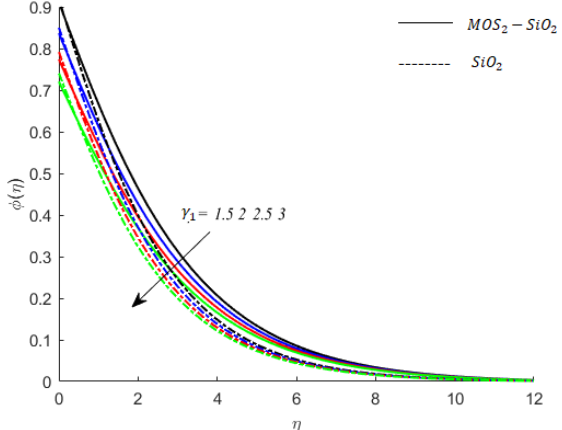
Figure 12. Influence of γ 1 on concentration when M = 0.9, Pr = 0.9, Ec = 0.2, Sc = 0.8, K = 0.1, Ei = 0.1, Bi = 0.05, β ∗ = 0.1, γ = 0.1. Table 4. Local skin friction coefficient, Nusselt number, and Sherwood number for hybrid nanofluid = 0.1, K = 0.1, α = 0.3, ( MOS 2 − SiO 2 ) and nanofluid ( SiO 2 ) when M = 0.9, Sc = 0.8, ( Gr ) c Ei = 0.1, β ∗ = 0.1. Hybrid Nanofluid ( MOS 2 − SiO 2